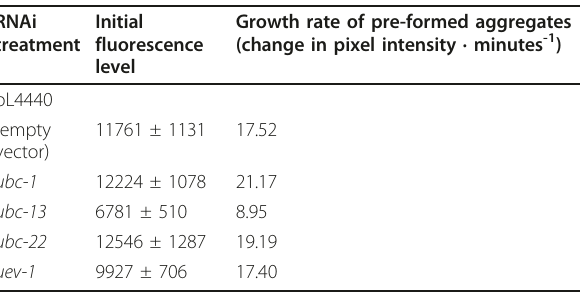
Table 2 Initial fluorescence levels and growth rates of pre-formed aggregates RNAi Initial treatment